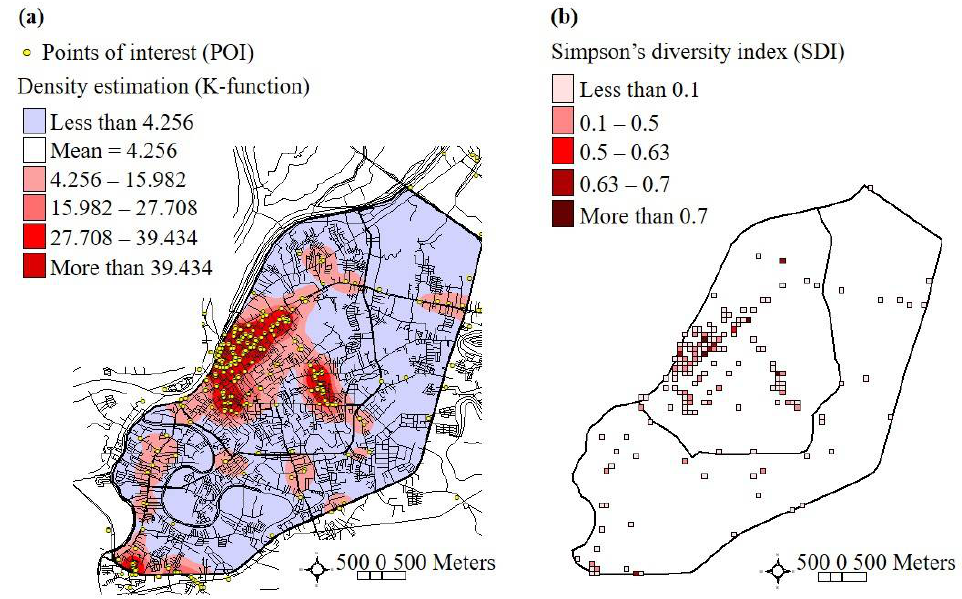
Figure 5. The spatial distribution of ( a ) the points of interest (POI) (mapped using kernel density in QGIS), and ( b ) the Simpson’s diversity index is used for the calculation of the diversity of zoning POI .